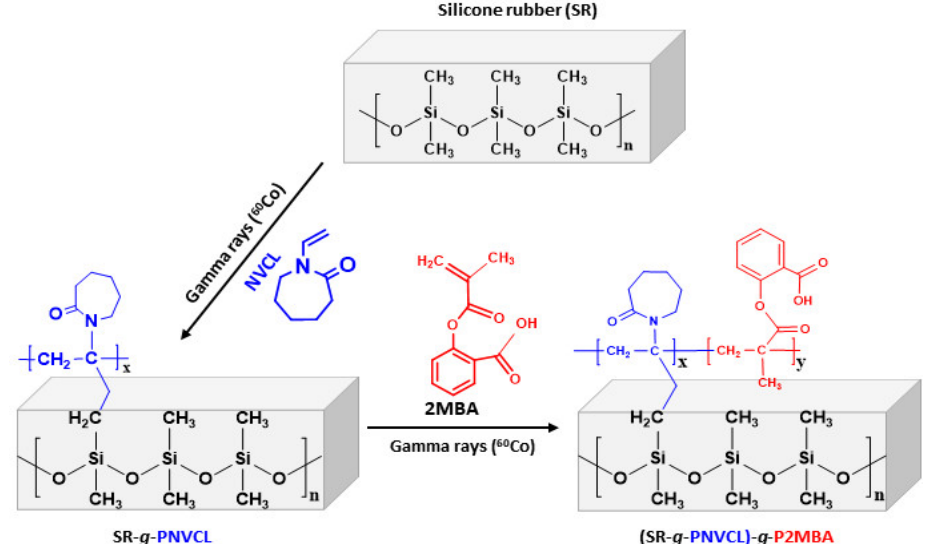
Figure 1. Functionalization of silicone rubber (SR) with NVCL and 2MBA by gamma radiation method.